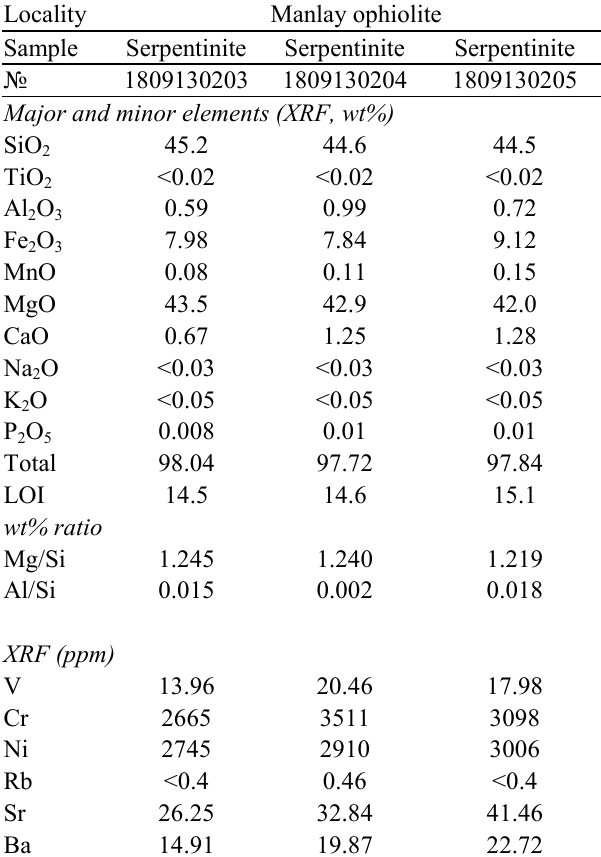
2. Bulk-rock major and minor element compositions of selected ultramafic rocks from the Manlay